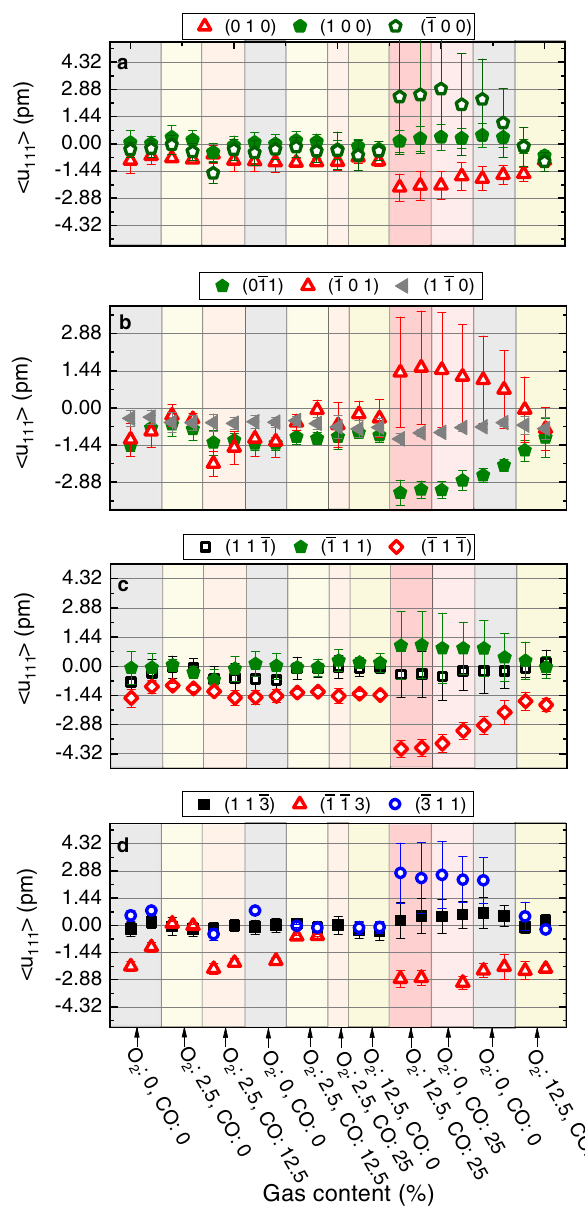
Fig. 7 Facet analysis of the displacement fi eld for NP300. Evolution of the average displacement fi eld for three selected facets of the four different facet subfamilies: a {100}, b {1 (cid:1) 10}, c {1 (cid:1) 11} and d {11 (cid:1) 3} facets. The evolution of three facets are shown with at least one of them experiencing large variations during the CO oxidation and one of them unaffected by the reaction. The error bars represent the standard deviation of the displacement per facet. The large inhomogeneous displacement observed during the stoichiometric CO oxidation reaction is re fl ected by large error